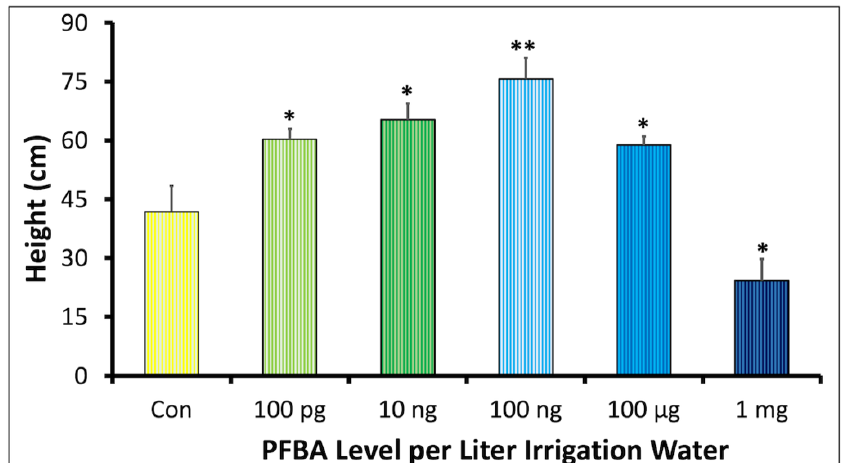
Figure 1. Dose–response relationship between the concentration of PFBA in irrigation water and plant height of soybean plants grown for 5 weeks. All plants received 1.4 L of irrigation water. The control group (Con) was irrigated with Nanopure water (Barnstead, Thermofisher) ( n = 3). Plant height data were fitted to the Brain–Cousens 4 parameter model. The f parameter suggests insignificant hormesis at p < 0.05 ( − 156 < f < 184). The * and ** symbols indicate significant difference between the treatment and control at p < 0.05 and p < 0.01, respectively.